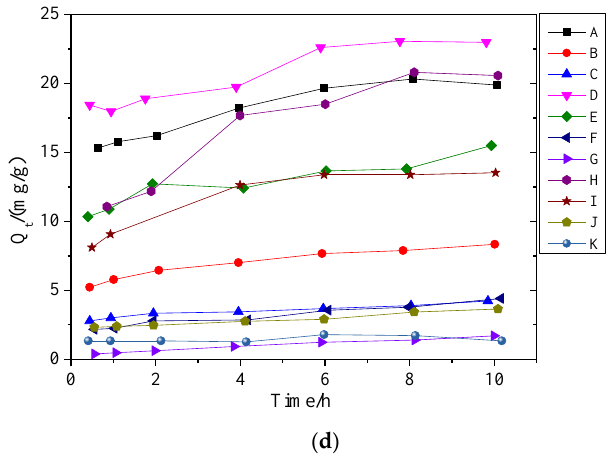
Figure 6. Adsorption dynamic curves of biochar and biochar-graphene composites for dimethyl phthalate (DMP), diethyl phthalate (DEP), and dibutyl phthalate (DBP); ( a ) DMP;( b ) DEP;( c ) DBP; ( d ) is the absorption rate change of o-benzene by biochar-graphene composites at different temperatures (A–D represent the absorption rate of BG 600 , B 600 , BG 300 , and B 300 for DMP; E–F represents the DEP absorption rate of BG 600 , B 600 , BG 300 , and B 300 . H-K represent the absorption rate of BG 600 , B 600 , BG 300 , and B 300 for DBP). Table 3. Kinetic parameters of adsorption of DMP, DEP, and DBP by biochar and BG composites. Names of Phthalate